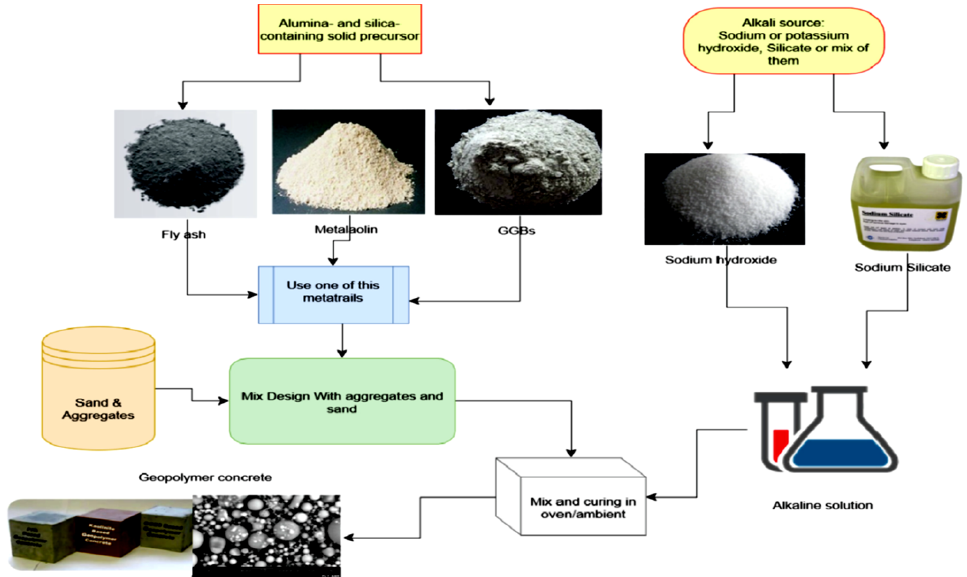
Figure 4. Production of GP. Adapted from [35].